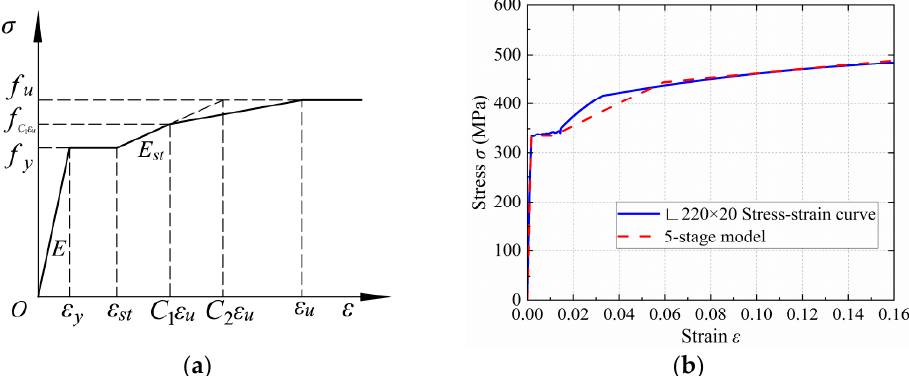
Figure 11. Constitutive model in the FE model: ( a ) the five-stage model; ( b ) the comparison between tested stress–strain curve and five-stage model.